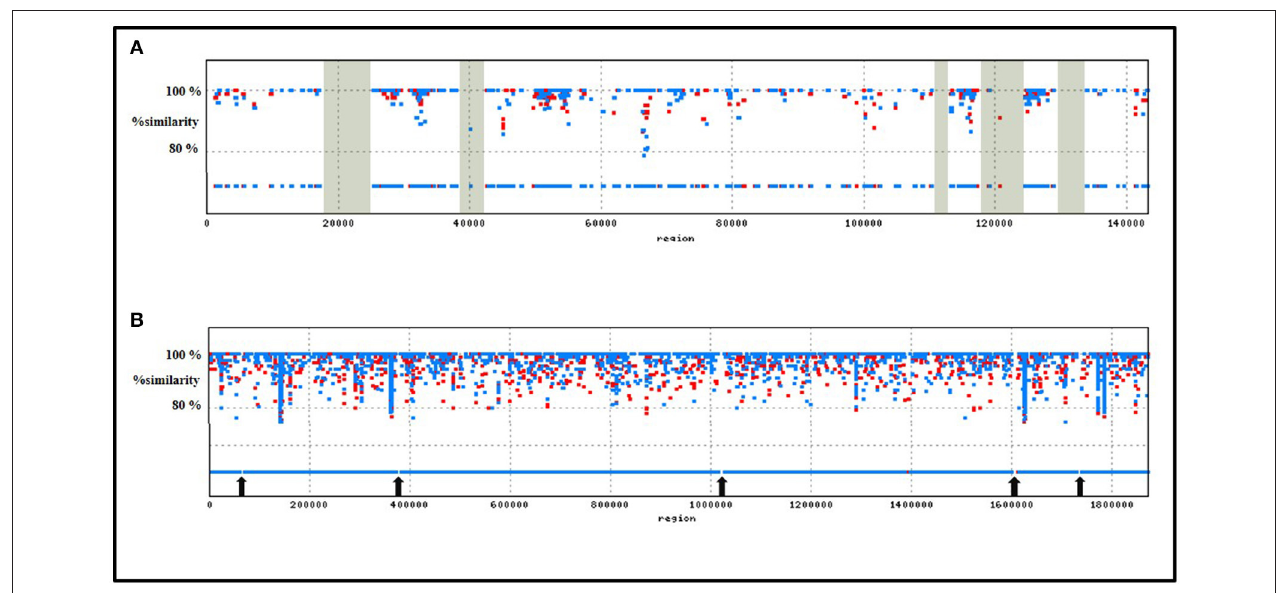
FIGURE 6 | Depiction of metagenomic islands recovered by recruitment of raw reads obtained from the metagenomic sequencing of hot spring water (Manikaran, India) onto T. parvatiensis plasmid (A) and chromosome (B) . MGIs on the plasmid pTP143 (5 MGIs) are highlighted in gray; MGIs on the chromosome of T. parvatiensis (5 MGIs) are marked with arrows. Reads mapped to the reference (identity ≥ 80%) are represented as blue (MNW1) and red (MNW2) dots.